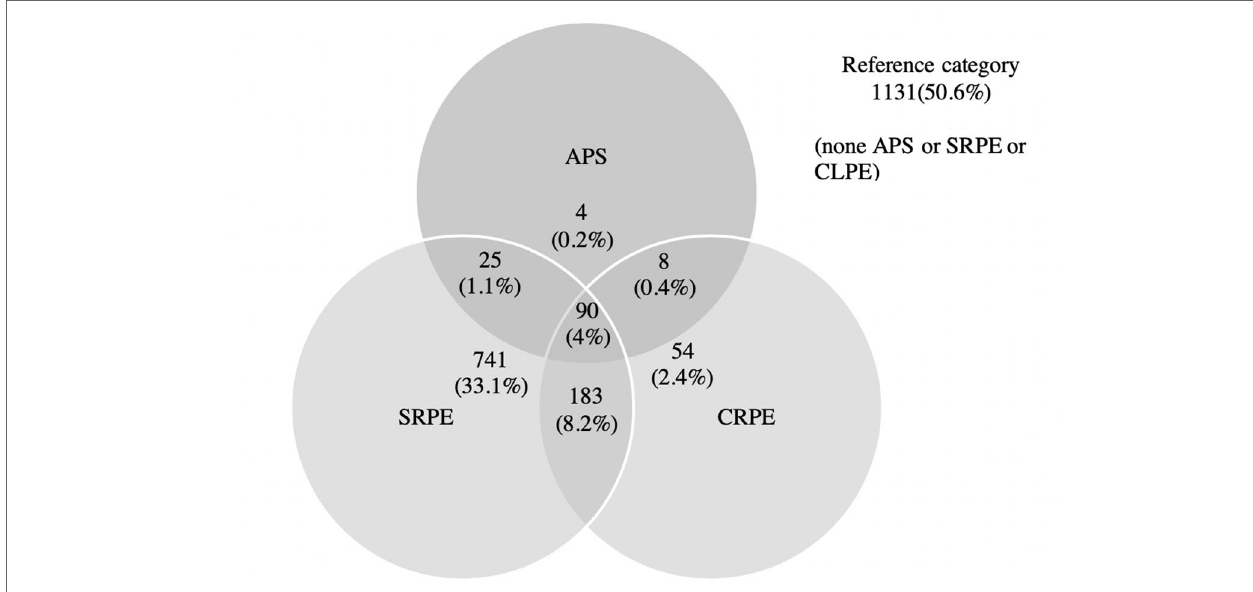
FiGURE 1 | Frequencies of subjects across different categories of the presence of self-reported psychotic experiences (SRPE), clinically validated psychotic experiences (CRPE), and attenuated psychotic symptoms